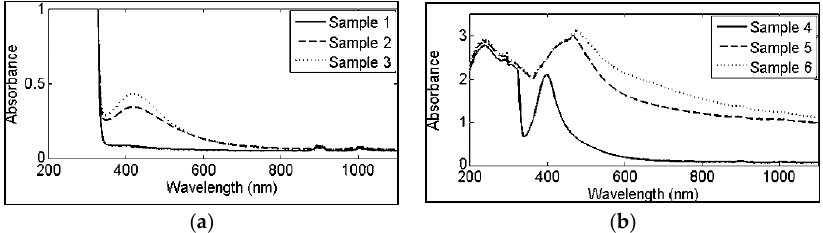
Figure 8. Absorption spectra of Ag nanoparticles in acetone prepared at ( a ) 532 nm wavelength; ( b ) 1064 nm wavelength at several fluences (samples 1 and 4: 14 J/cm 2 , samples 2 and 5: 18 J/cm 2 , samples 3 and 6: 22 J/cm 2 ). Reprinted from [175], with permission from Springer